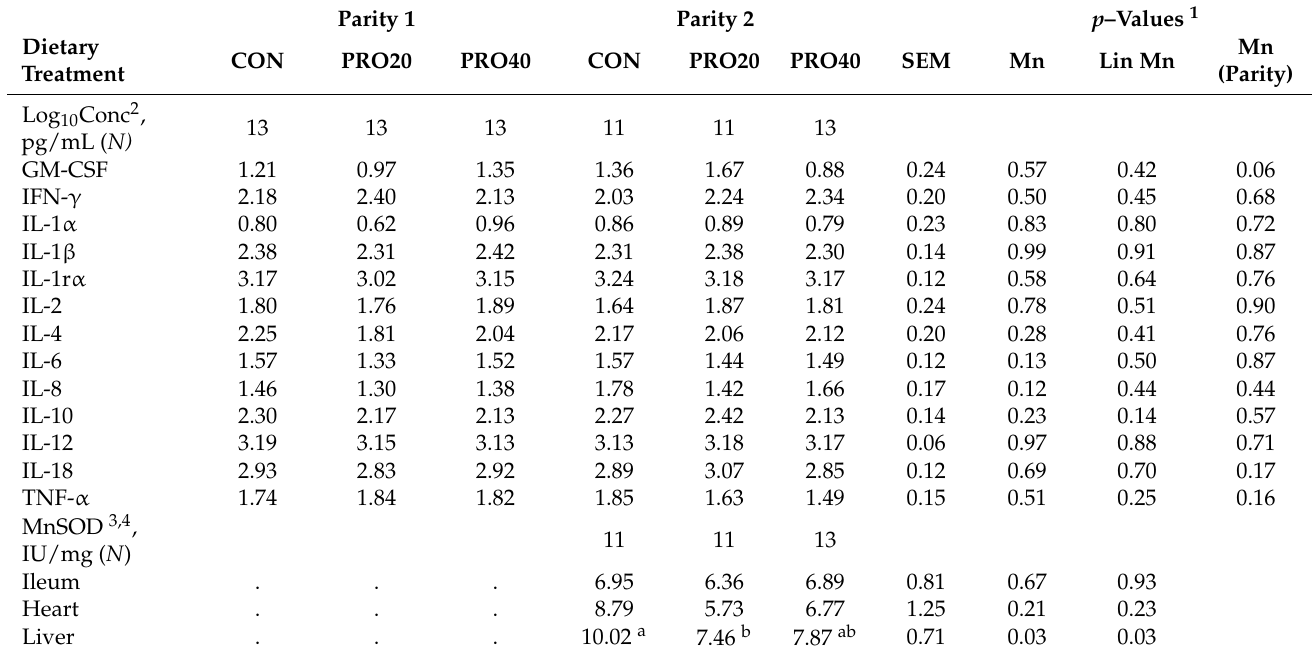
Table 4. The effect of maternal supplemental dietary manganese on the log concentration of plasma immune markers in piglets 5 d post-weaning and MnSOD tissue activity at weaning. Parity 1 Parity 2 p –Values 1